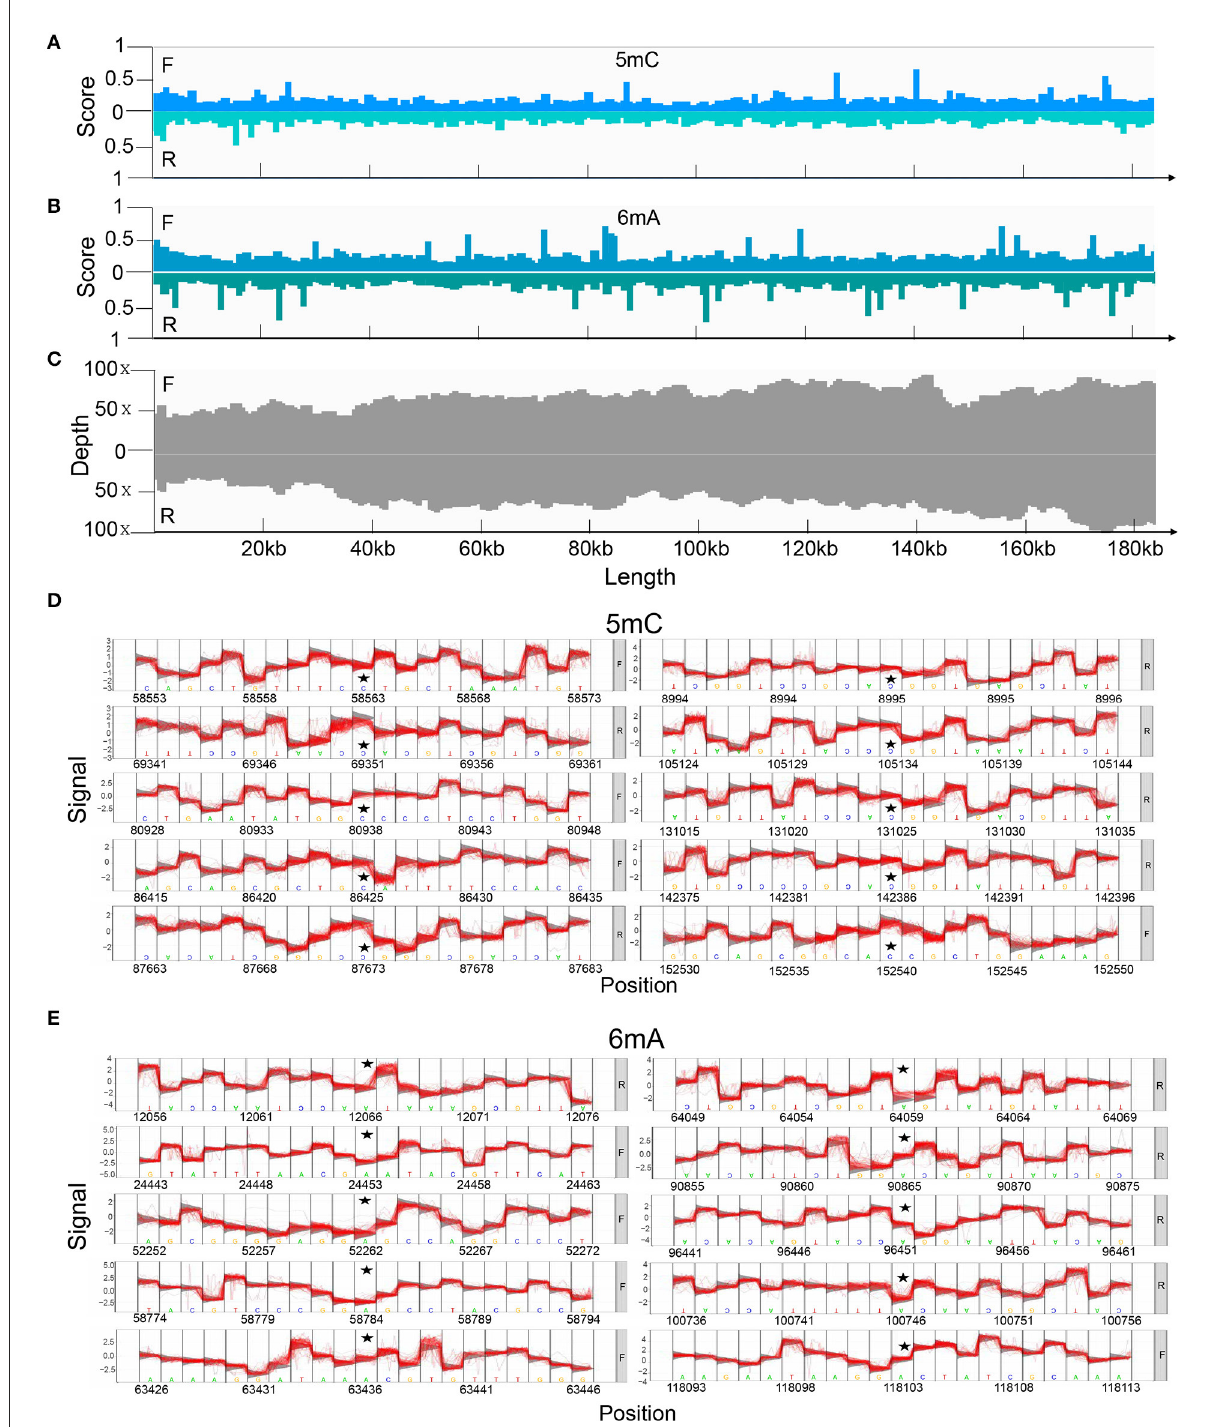
FIGURE4 Methylation of positive and reverse strands in the genome predicted using Tombo and its corresponding depth. (A) The score of 5mC and (B) 6mA modification of positive and reverse strands. We compared the raw signal levels between sequenced samples and alternative models to obtain the statistical results of the corresponding sites, Tombo generated the correlation scores to evaluate the possibility of methylation on certain sites in the full-length viral genome. A higher score indicated that the site was more likely to undergo methylation modification. (C) Depth of Nanopore sequencing of positive and reverse strands. The top 10 methylation sites and their adjacent regions in the ASFV_GZ201801_2 that are most likely to be modified by (D) 5mC and (E) 6mA methylation also predicted using